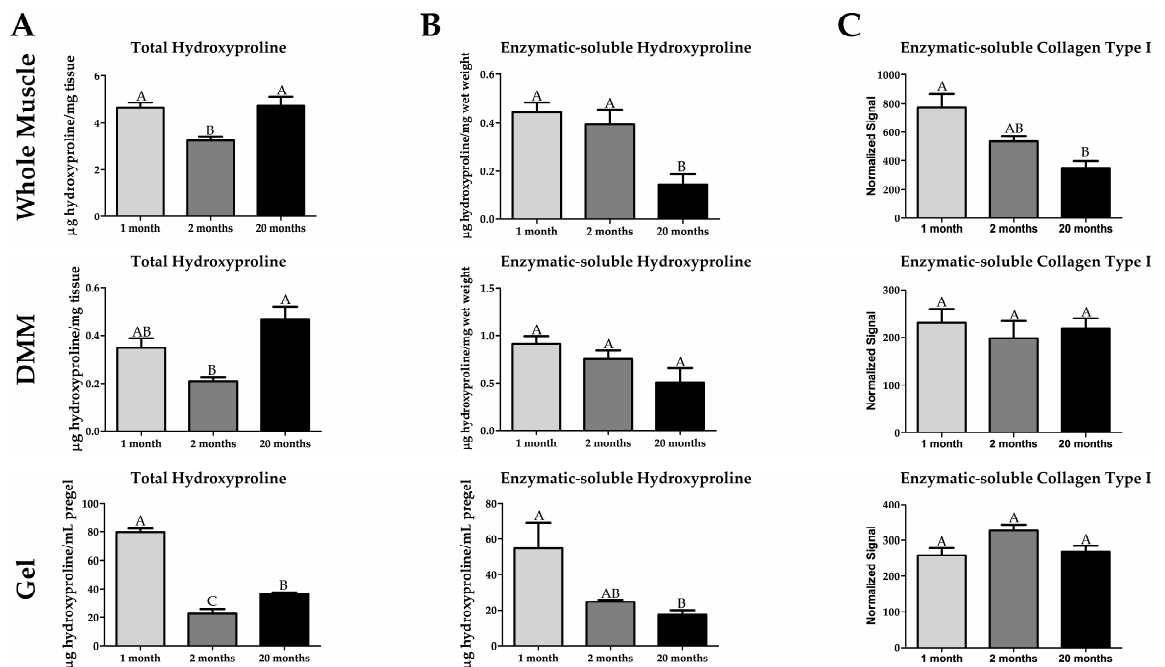
Figure 5. Total collagen is elevated in old age while soluble collagen is reduced as seen by hydroxyproline assays and SDS ‐ PAGE. ( A ) Total hydroxyproline is increased at 1 month and 20 months compared to 2 months in whole muscle (n = 5 for 1 and 20 months, n = 6 for 2 months), decellularized muscle matrix (DMM) (n = 5 for 1 ‐ month, n = 6 for 2 and 20 months), and processed DMM gels (n = 3 for all groups), except 1 month is not higher than 2 ‐ month levels in DMM. Furthermore, total hydroxyproline levels are higher at 1 month in processed DMM gels compared to 20 months. ( B ) The amount of hydroxyproline soluble to the enzyme proteinase K is reduced in 20 months in whole muscle compared to 1 and 2 months and to 1 month in DMM (n = 5 for all groups) and processed DMM gels (n = 3 for all groups), indicating increased levels of cross ‐ linking. ( C ) There is a decreased amount of proteinase K ‐ soluble Collagen Type I at 20 months as determined by SDS ‐ PAGE immunostaining compared to 1 month in whole muscle, indicating an increase in cross ‐ linking. In DMM (n = 5 for all groups) and DMM processed gels (n = 3 for all groups), there is no difference in soluble Collagen Type I due to age, which could be due to the processing of the collagen denaturing the structural epitopes that the collagen antibody recognizes.Groups that do not share a letter (e.g. A, B, or C) are statistically different according to a one ‐ way ANOVA followed by a two ‐ tailed Tukey’s correction ( p < 0.05, n value is detailed in each section).